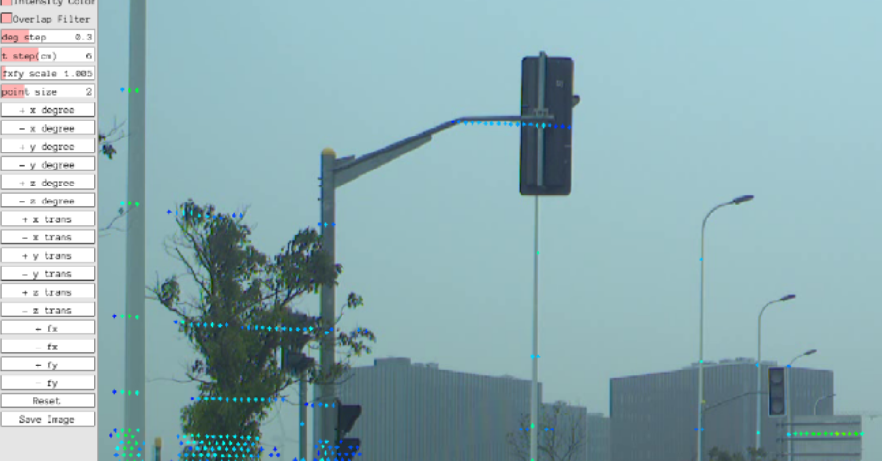
Figure 3. OpenCalib UI when calibrating an RGB w.r.t. a